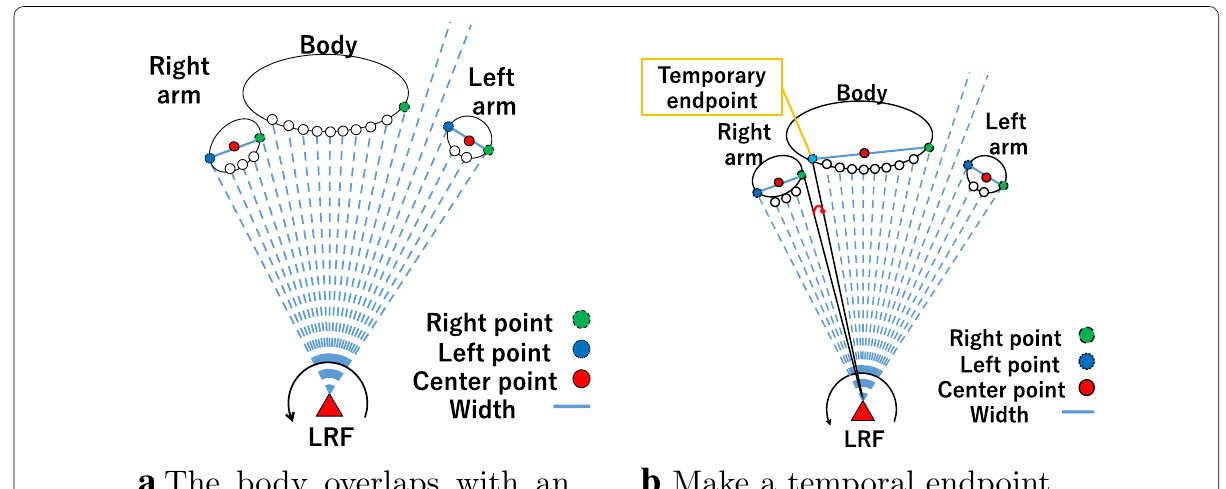
Fig. 7 Determination of temporary